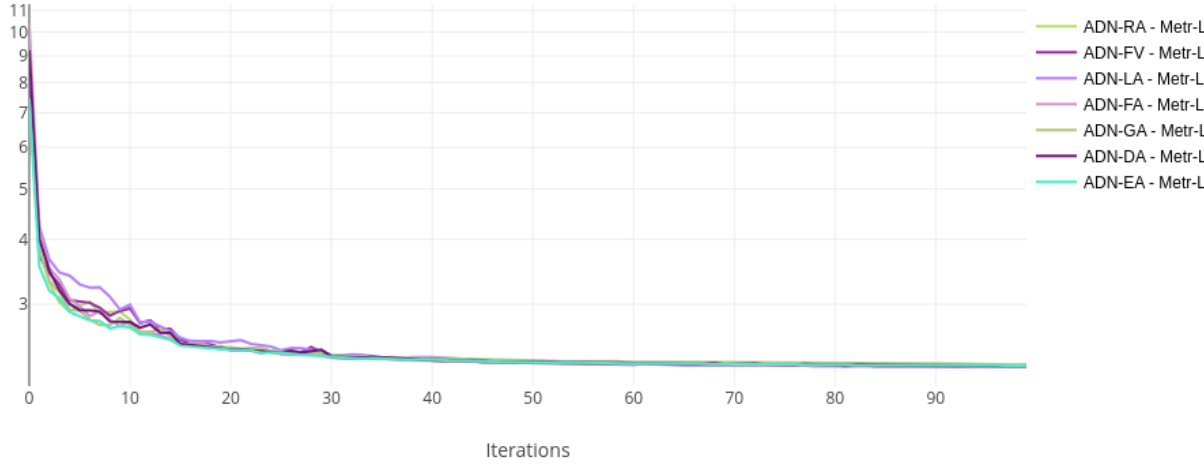
Figure 2. Training loss curves, log scale—ADN on